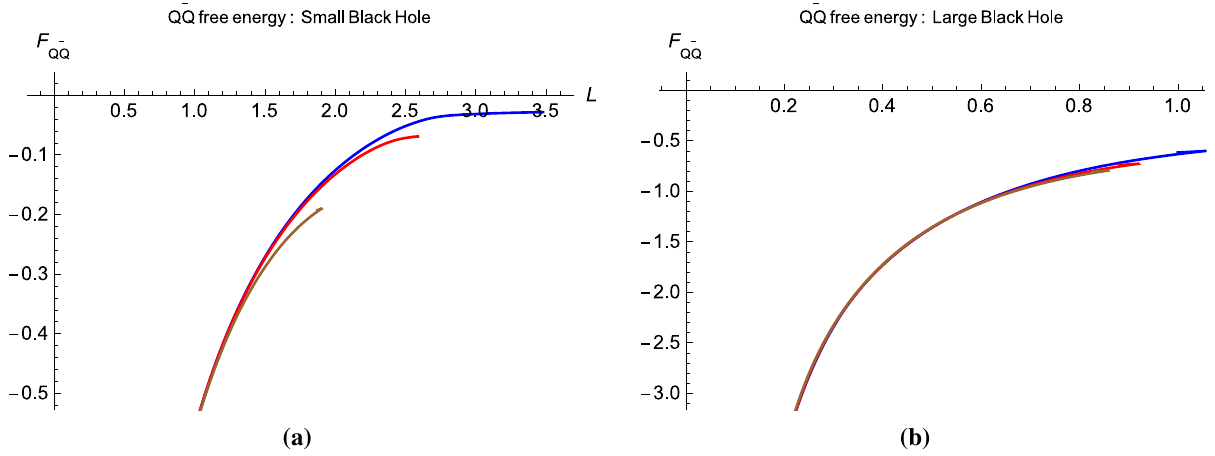
Fig. 14 Q ¯ Q free energy vs. L for ¯ a = . 05; T = . 441; ¯ α = .001 (blue), .004 (red), .0082 (brown) a small black hole, b large black